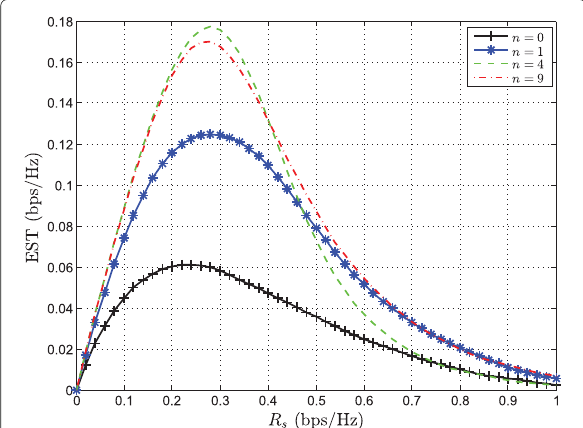
Fig. 8 Simulation results of EST for alternative scheme on basis of SNR = 3 dB